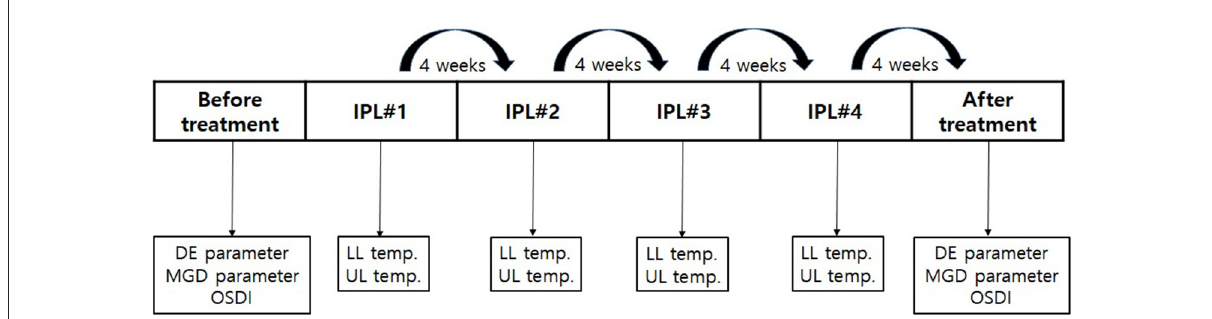
FIGURE3 The schedule of IPL treatment and clinical measurements. DE and MGD parameters and the OSDI were measured before the first IPL treatment and after the fourth IPL treatment. The skin temperatures were measured before every IPL treatment. IPL, intense pulsed light; DE, dry eye; MGD, meibomian gland dysfunction; OSDI, Ocular Surface Disease Index. IPL, intense pulsed light; DE, dry eye; IPL#1, first intense pulsed light treatment; IPL#2, second intense pulsed light treatment; IPL#3, third intense pulsed light treatment; IPL#4, fourth intense pulsed light treatment; MGD, meibomian gland dysfunction; OSDI, Ocular Surface Disease Index; LL, lower eyelid; UL, upper eyelid.